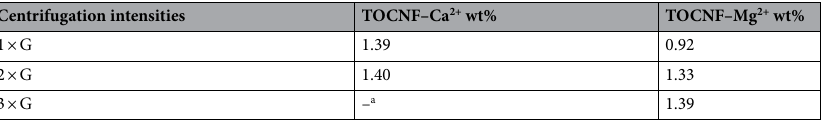
Table 3. Solid contents of 3D printed TOCNF–Ca 2+ and TOCNF–Mg 2+ hydrogels at the ratio of 1:1:25 with various centrifugation intensities. a Not measured, because no need for 3 × G at TOCNF–Ca 2+ .